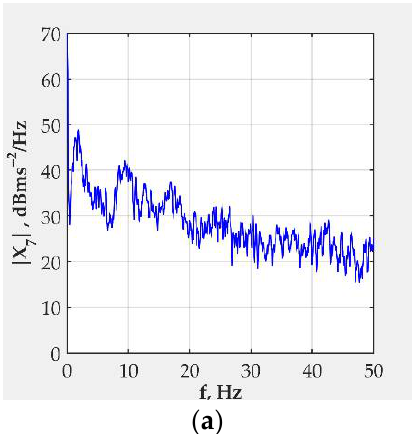
Figure 9. Magnitudes of output spectra: ( a )